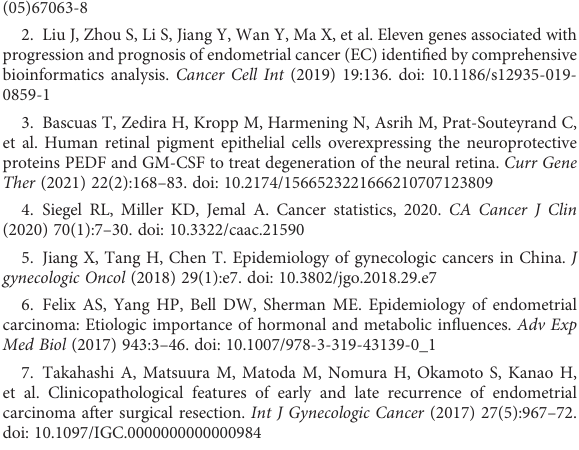
Heatmap of the top 50 differentially expressed